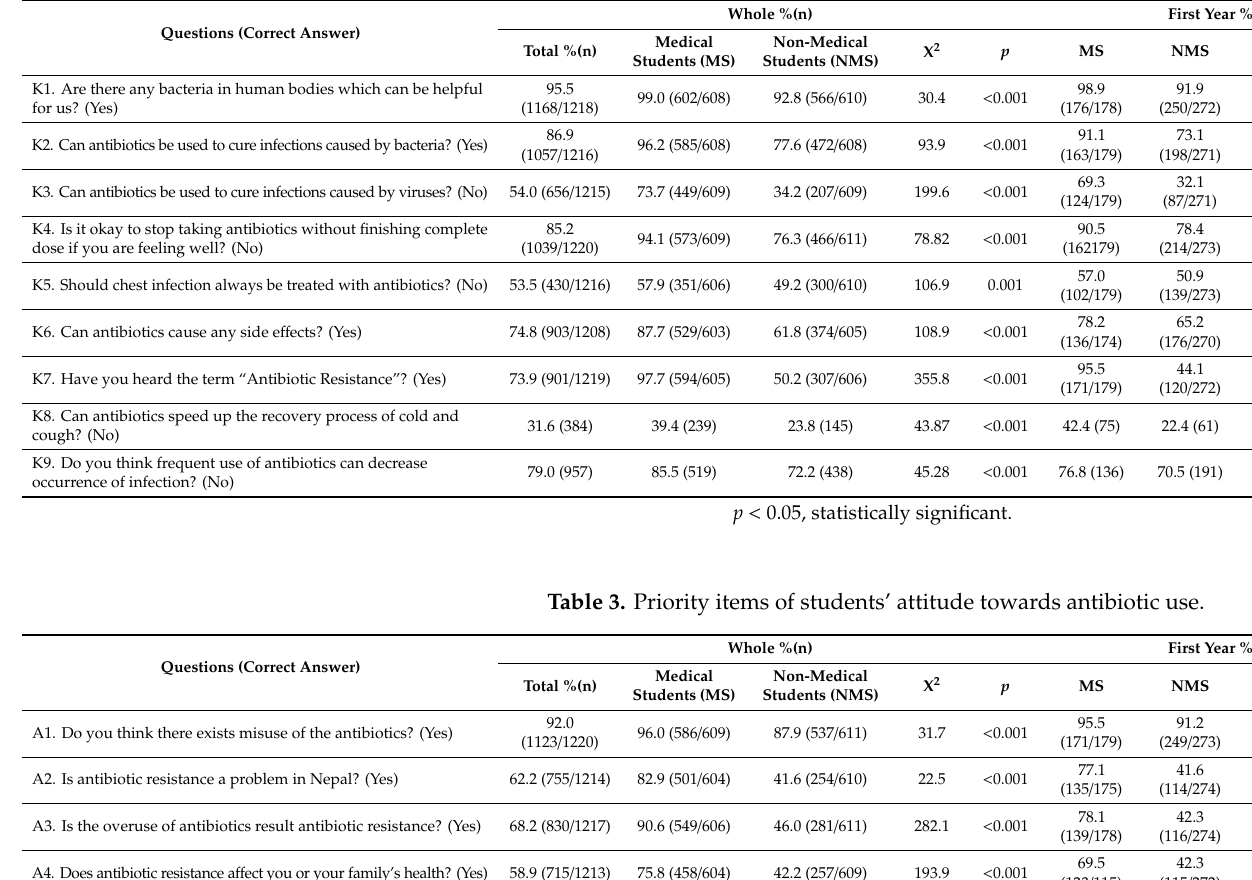
Table 2. Priority items of students’ knowledge about antibiotic use.